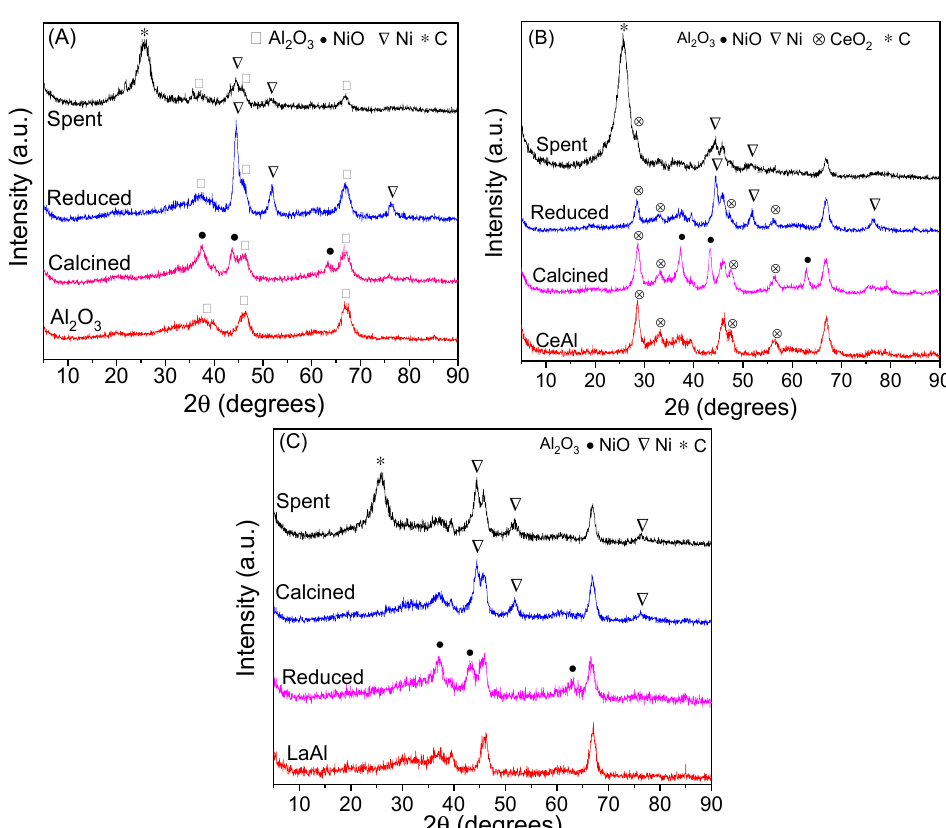
Figure 2. XRD patterns in different stages (support, calcined, reduced, and spent catalysts) of NiAl ( A ), NiCeAl ( B ), and NiLaAl ( C ). Peaks related to CeO 2 at 28.6 (1 1 1), 33.2 (2 0 0), 47.8 (2 2 0) and 56.4° (3 1 1) (JCPDS